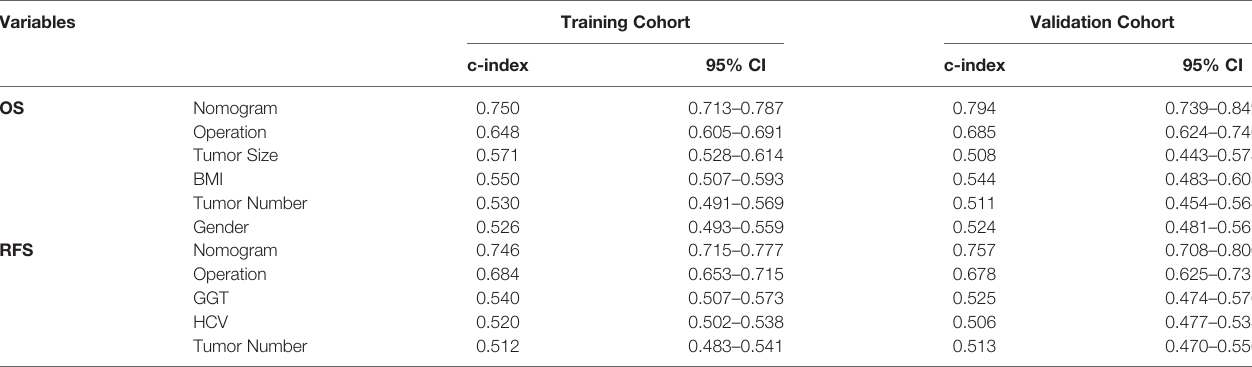
TABLE 3 | Ranking of clinical staging system using C-index for OS and RFS in the training and validation cohorts. Variables